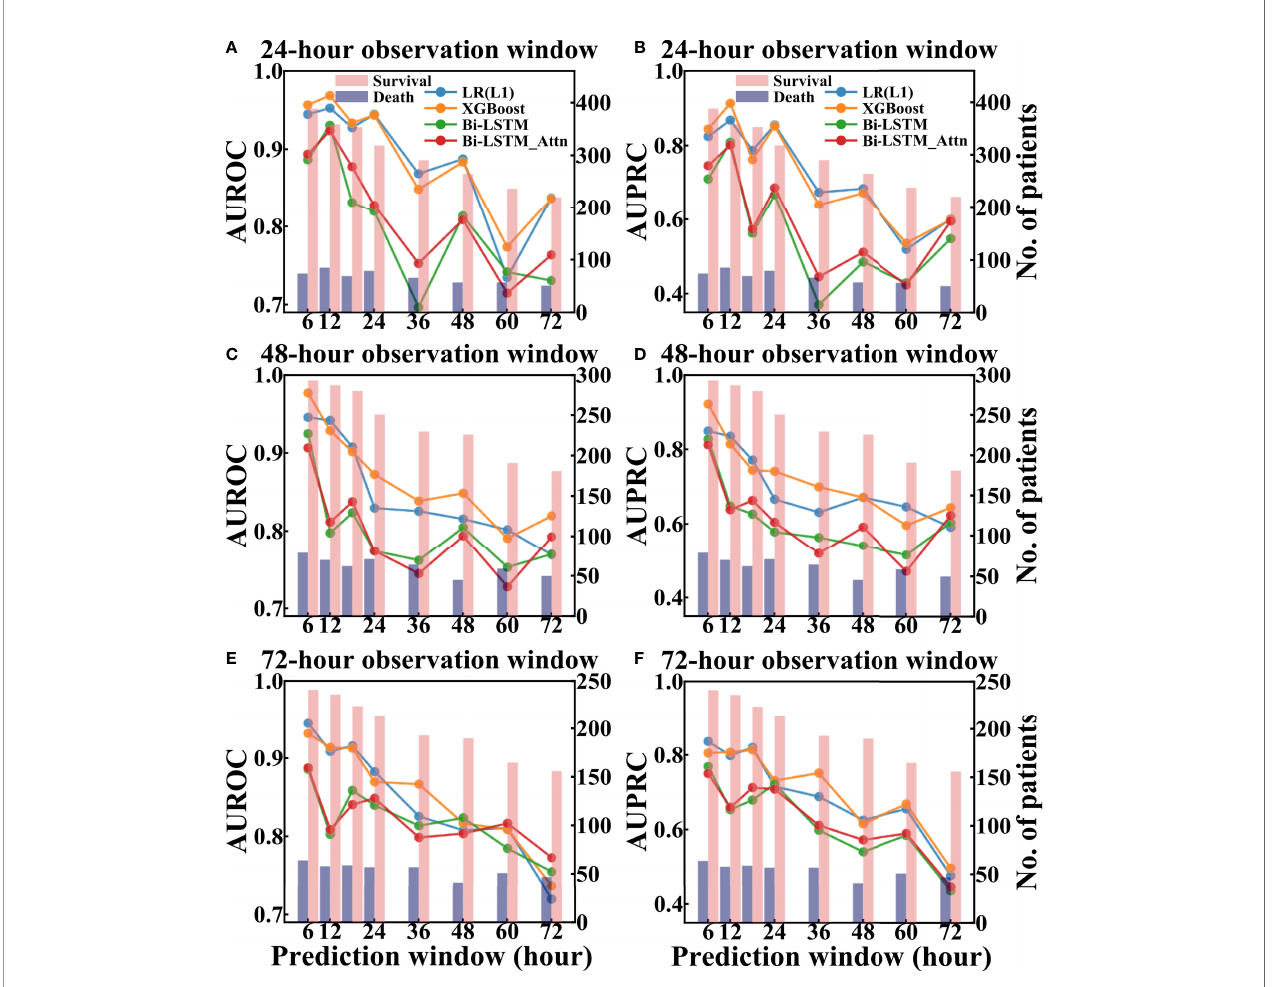
FIGURE 7 | Performance of different models to predict pneumonia patient survival using different prediction and observation windows based on the test set of MIMIC-III. The left column showed AUROC values and the right column showed AUPRC values. (A, B) are AUROC and AUPRC of different models under different 24-hour observation windows and different prediction windows, respectively. (C, D) are AUROC and AUPRC of different models under different 48-hour observation windows and different prediction windows, respectively. (E, F) are AUROC and AUPRC of different models under different 72-hour observation windows and different prediction windows,